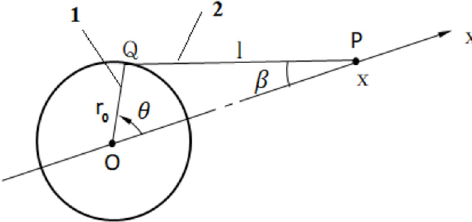
Fig. 3. Motion schematic diagram of crank slider mechanism.